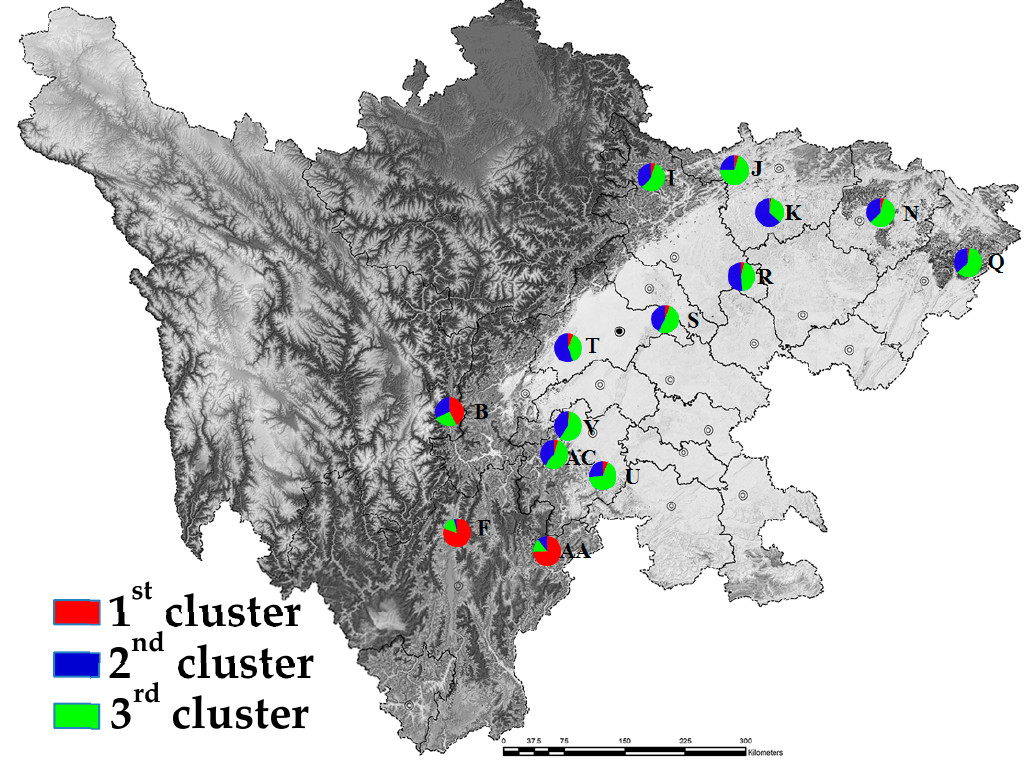
Figure 4 . Mean proportions of cluster memberships of analyzed individuals in each of the 14 A. cremastogyne populations based on STRUCTURE at K=3.